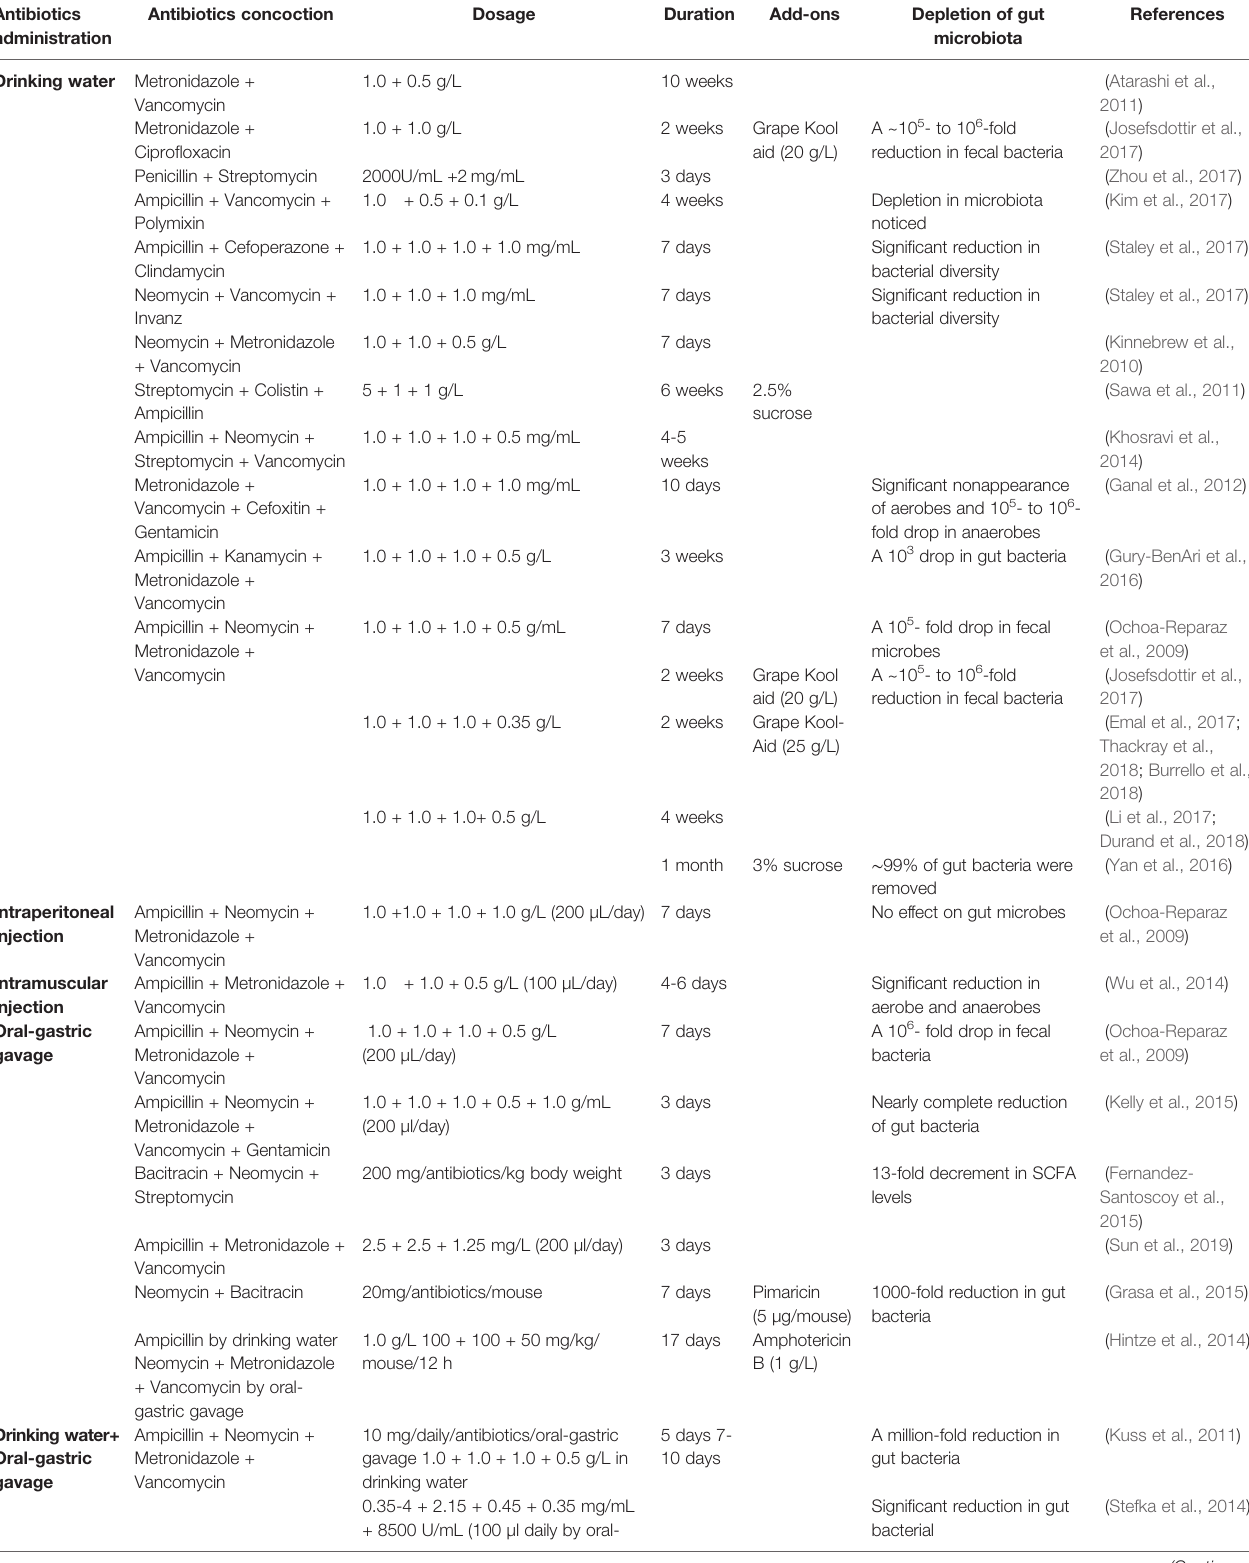
TABLE 1 | Antibiotics regimens for depletion of the gut microbiota in recipient